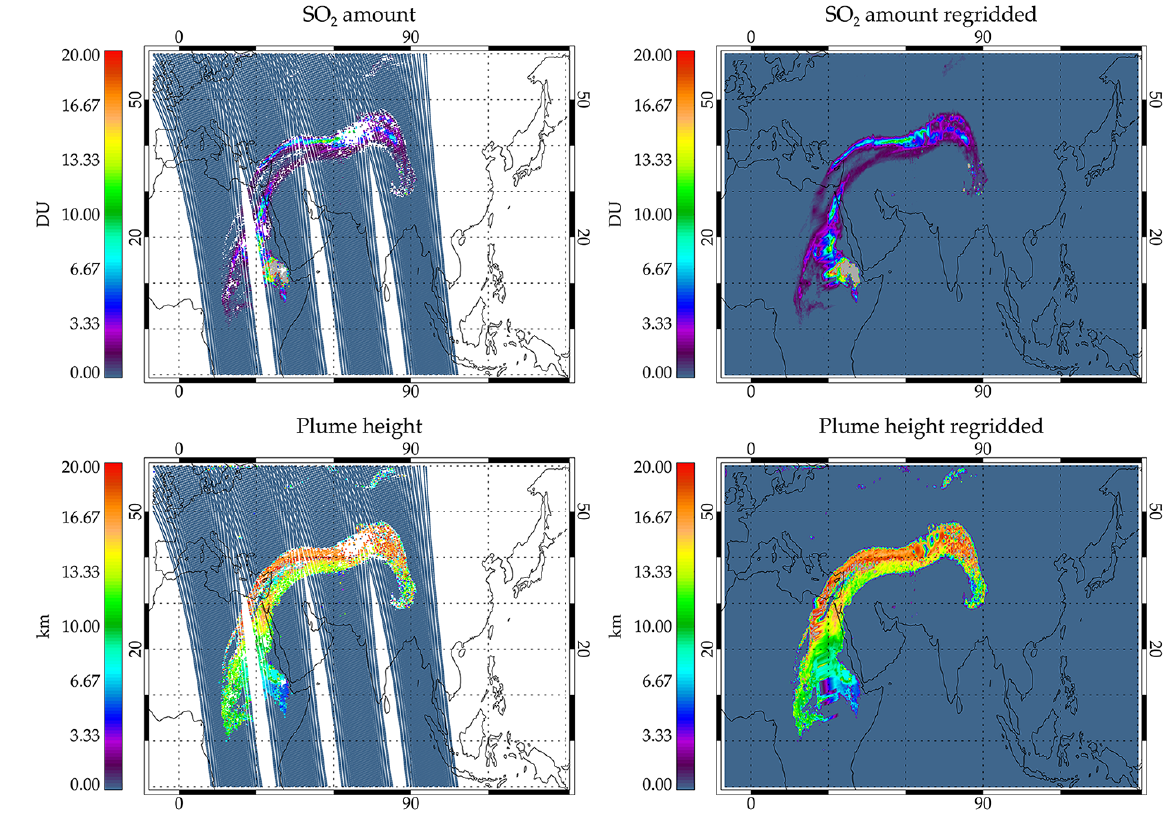
Figure 6. Maps of IASI SO 2 amount (top left) and height (bottom left) and the equivalent maps of SO 2 amount (top right) and height (bottom right) obtained after regridding. Grey colour indicate values higher than the colour bar. The IASI data are a combination of four orbits on the 15 June 2011 from 13:00 to 18:00UTC during Nabro